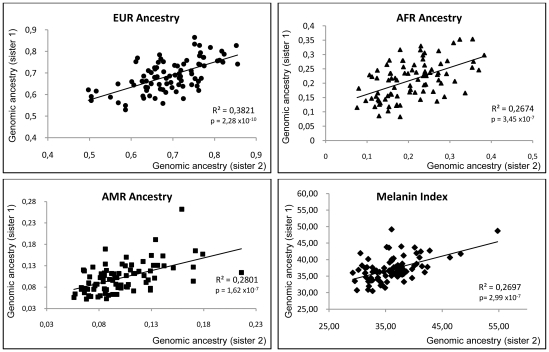
Scatter plot from ancestry proportions and pigmentation between siblings.